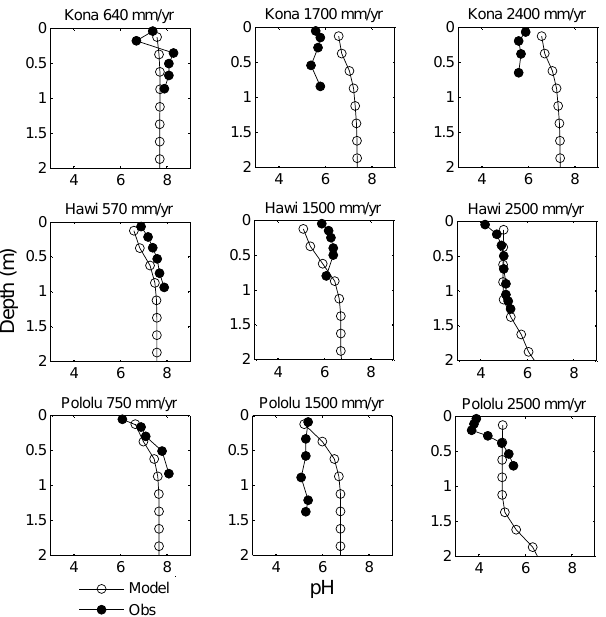
Figure 11. Observed vs. simulated pH for 3 sites on each of the lava